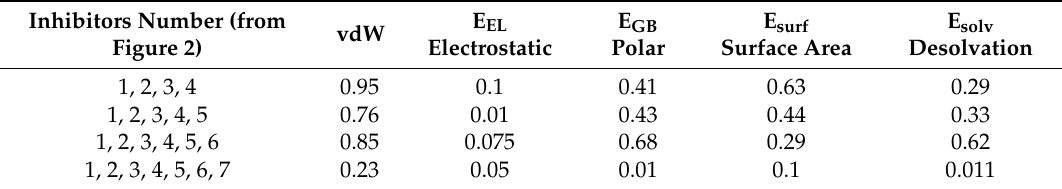
Figure 5. The breakout of binding energy Δ H to its contributing energies for inhibitors under study. The flap, a β -hairpin loop containing residues Tyr71to Val69, positioned directly over the catalytic dyad, can open and close to allow substrate and inhibitor access to the active site; see Figures 1 and 6A.